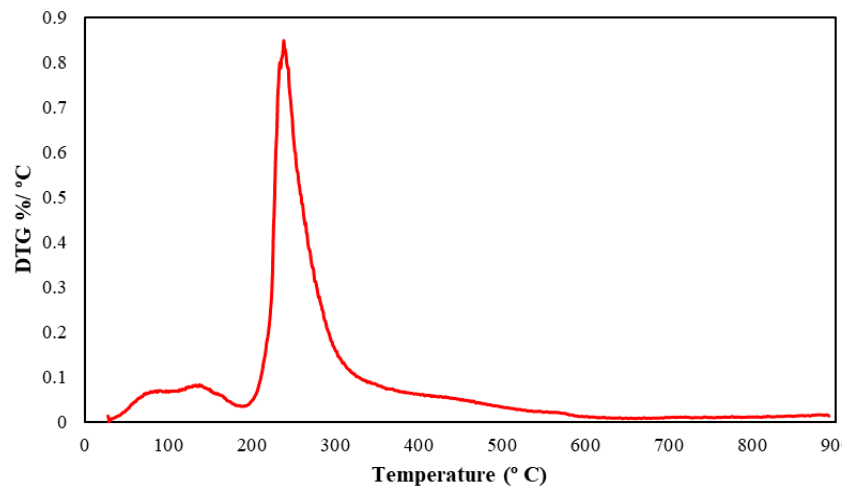
Figure 8. Derivative thermogravimetric profile of 2:1 molar ratio inulin–TEOS hybrid adsorbent. The static contact angle was measured on the 2:1 inulin–TEOS hybrid adsorbent using the sessile drop method. The contact angle was 31.1°, as shown in Figure 9, indicating that the adsorbent exhibited hydrophilicity, which is quite beneficial for adsorbents in an aqueous system [37].